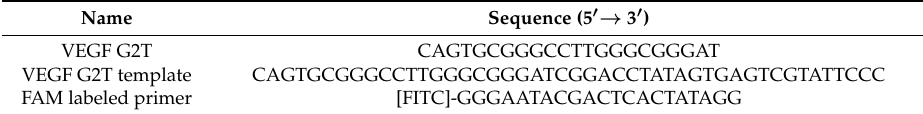
Figure 2. Structures of ligand-containing guanine oligonucleotides used in this study. ( A ) Chemical structures of the ligand-containing linkers. ( B ) Structures of ligand-conjugated guanine tracts. The attachment of a ligand-containing linker was either to the 3 (cid:48) or 5 (cid:48) OH group of the respective deoxyguanosine residue via the phosphodiester linkage. Table 1. Nucleotide sequences used in this